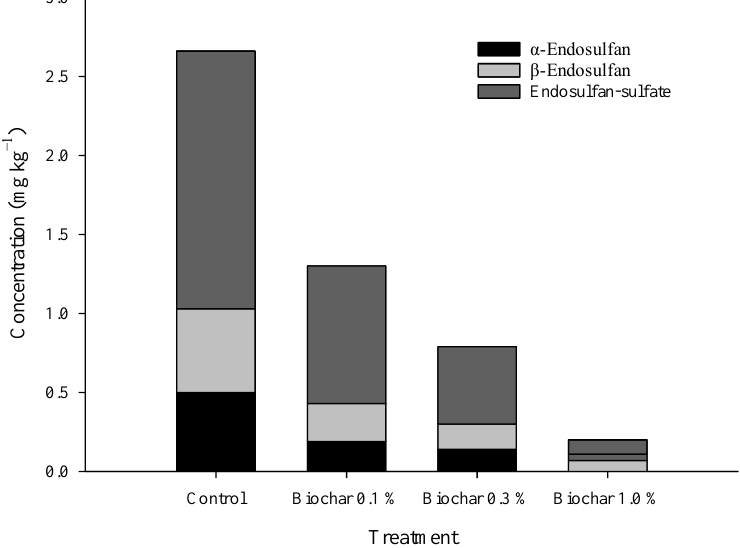
Figure 7. Endosulfan concentration of two-year-old ginseng under different biochar treatments.